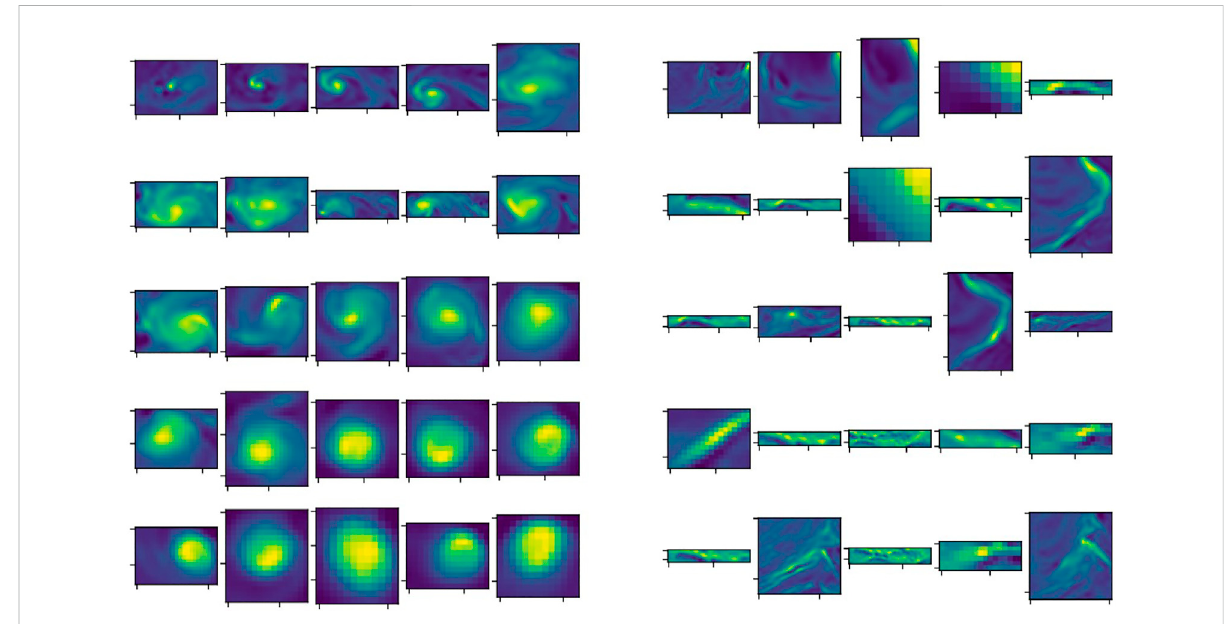
FIGURE 7 Some relative vorticity fi elds of TCs (left) and noise (right), which was captured during running the tracking